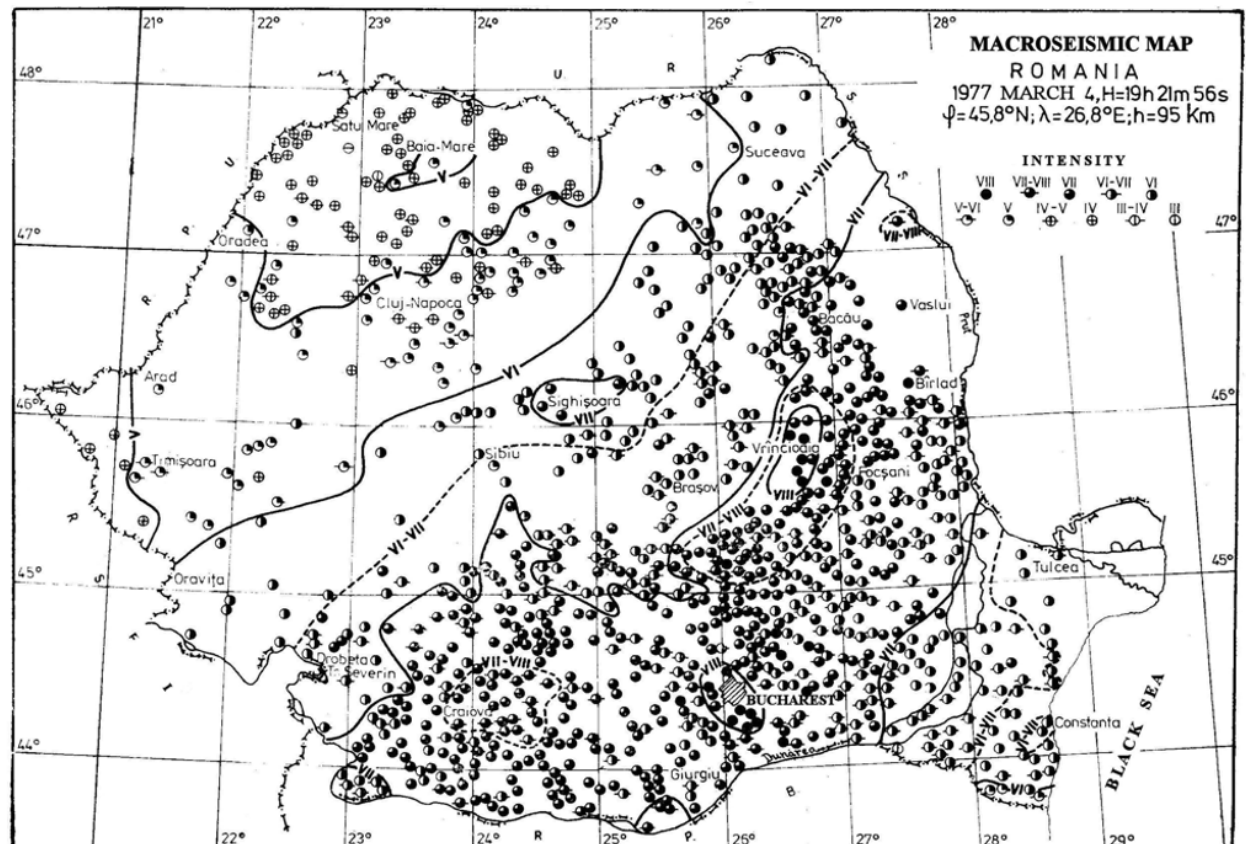
Figure 6. Macroseismic map for the March 4, 1977, Vrancea earthquake, as drawn up by Radu et al.